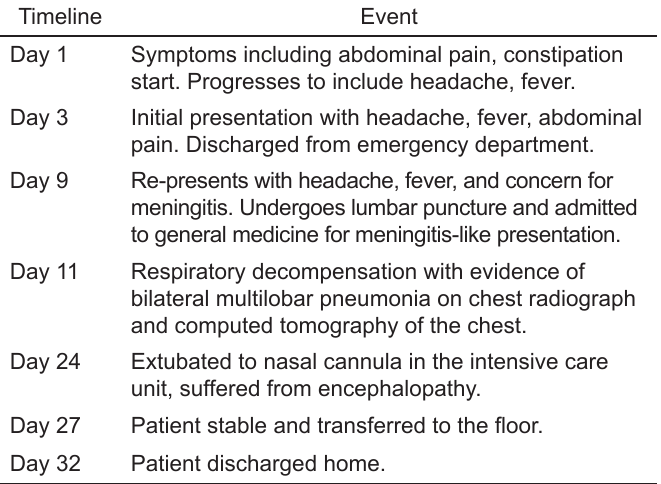
Table 1. Clinical course from onset of atypical symptoms until discharge of patient with presumptive coronavirus